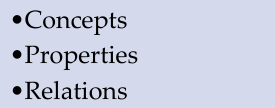
Figure 4. The main structure of security ontology data source layer: blue elements — classes; gray elements — data properties of the class; purple elements — class of mapping layer; arrows — data properties, connecting the instances of separate classes.